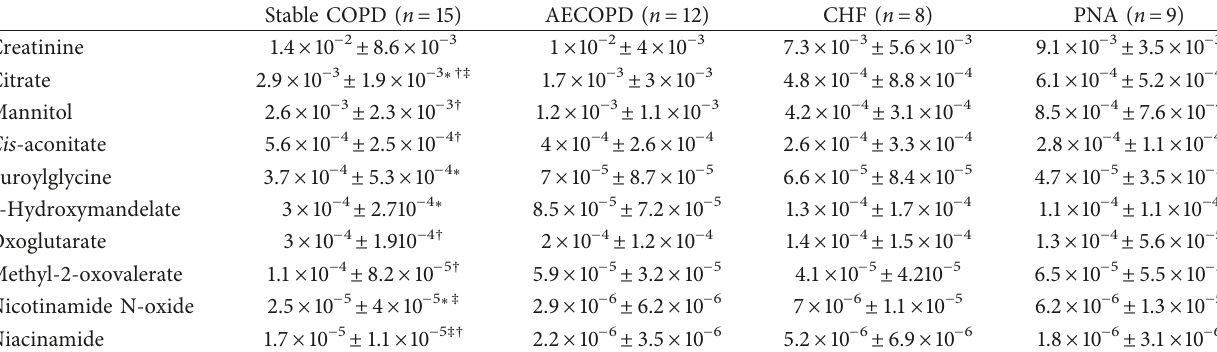
Table 3: Concentration (millimoles of metabolite per millimoles of total solute) of the top 10VIP metabolites in urine of subjects with stable COPD, AECOPD, CHF, and